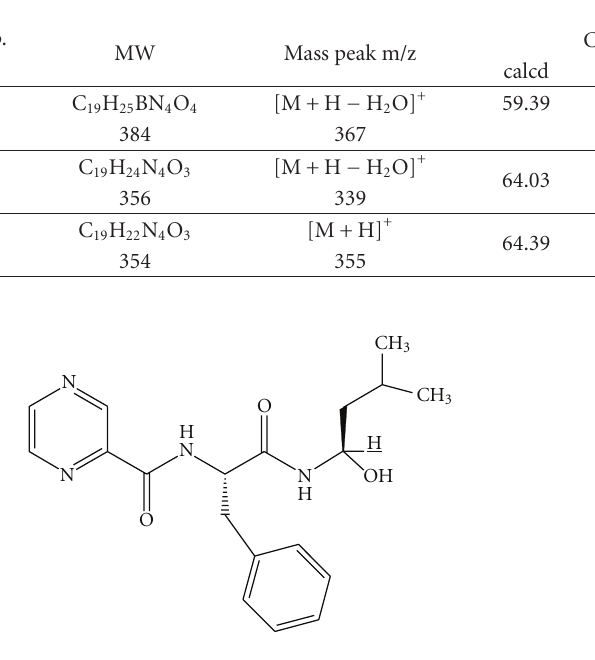
Figure 4: N-(1-(1-hydroxy-3-methylbutylamino)-1-oxo-3- phenylpropan-2-yl) pyrazine-2-carboxamide ( BTZ1 ).